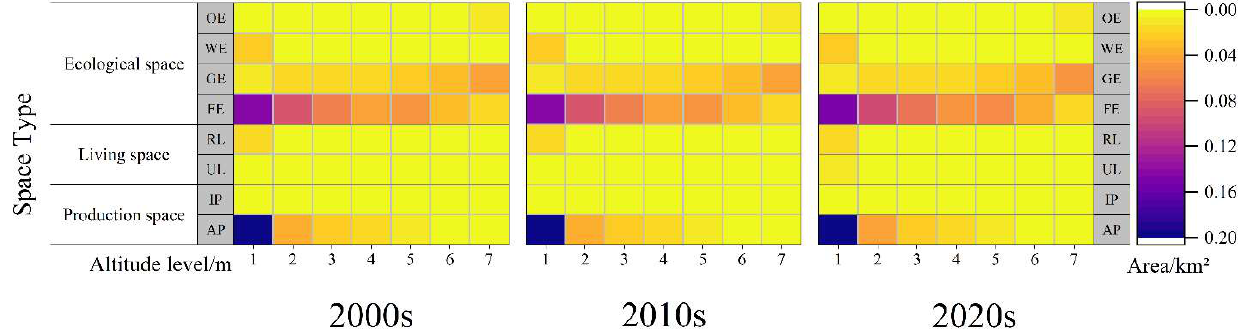
Figure 4. Elevation terrain distribution index of the territorial space of the Yangtze River Economic Belt from 2000 to 2020.